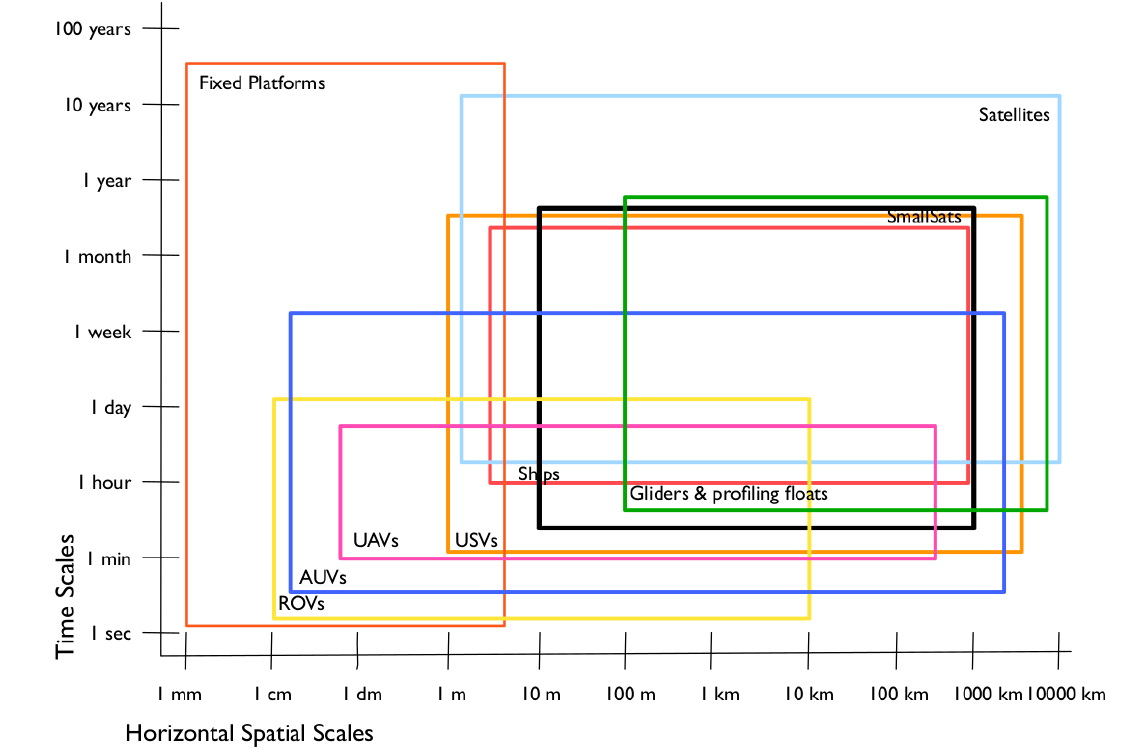
Figure 1. Temporal and spatial scales of marine systems. Figure modified from